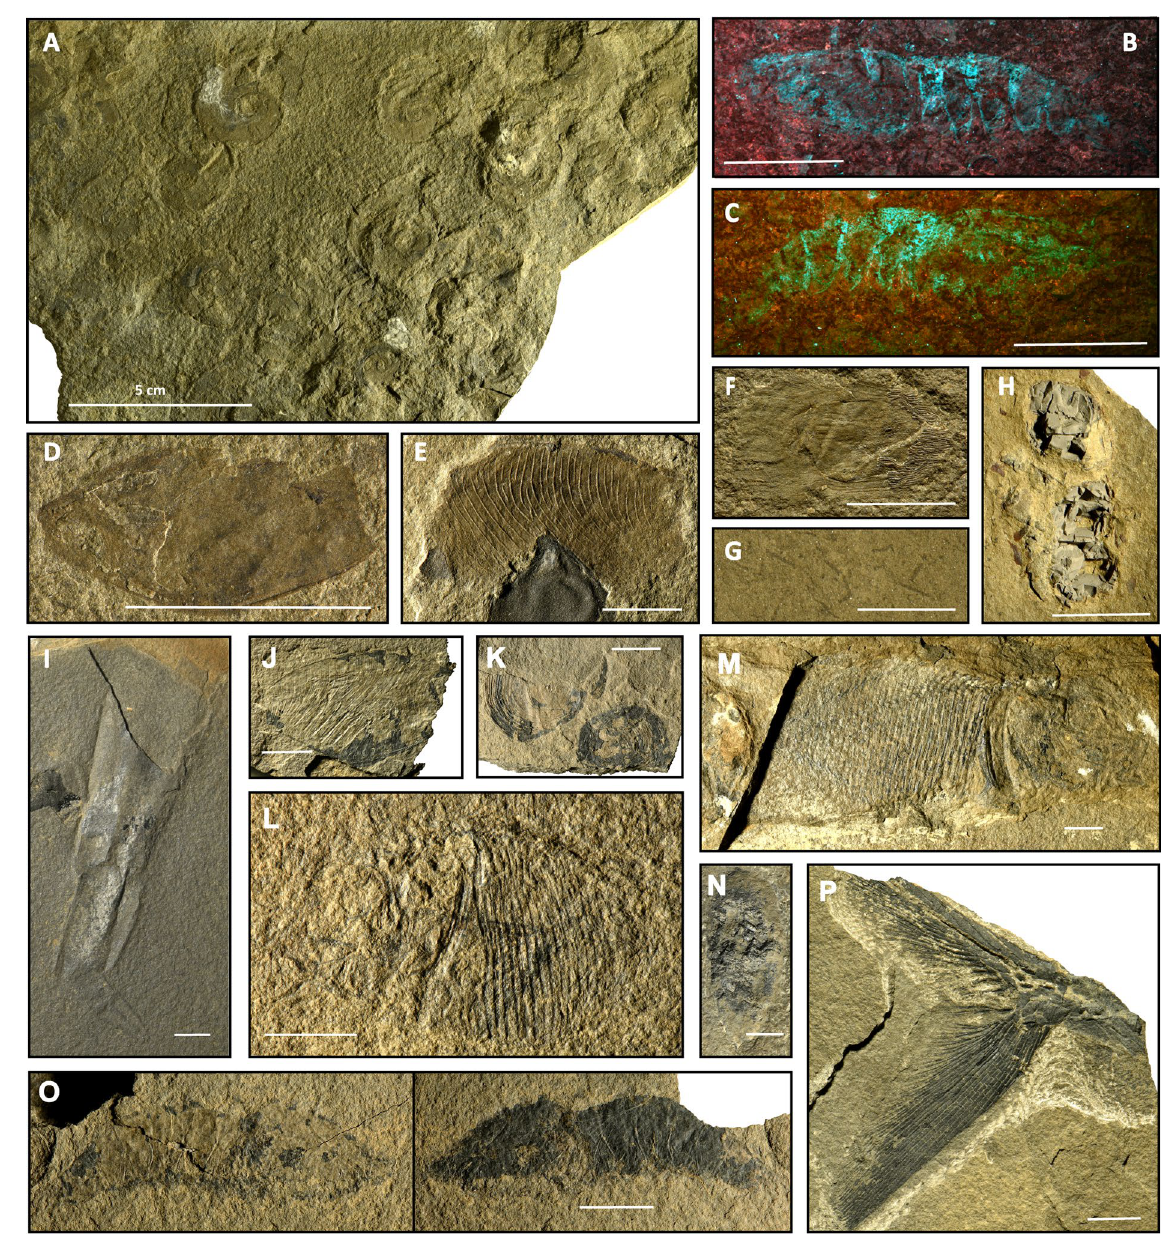
Figure 3. ( A – H ) Components of the GT fossil assemblage. ( I , J ) Components of the STW fossil assemblage. ( A ) Agglomerated ammonoids (UBGD33012) . ( B , C ) Penaeoid shrimps under UV light (UBGD33011a; UBGD33011b) . ( D ) Thylacocephalan Ligulacaris parisiana (UBGD33010) ( E ) Thylacocephalan Ankitokazocaris triassica (UBGD32321) . (F ) Isolated coelacanth scale (UBGD33009). ( G ) Algae accumulation (UBGD33008) . ( H ) Vertebrate coprolite (UBGD33007) . ( I ) Orthoconic nautiloid (UBGD33005). ( J ) Thylacocephalan Ankitokazocaris triassica (UBGD.IMNH2) . (K ) Brachiopod Orbiculoidea (UBGD33015) . ( L ) Fish Bobasatrania (UBGD.IMNH4). ( M ) Fish Bobasatrania sp. (IMNH_2740_51487) . ( N) Vertebrate coprolite (UBGD33006) . ( O ) Penaeoid shrimp (UBGD33014) . ( P ) Fish Bobasatrania sp. caudal fin (UBGD.IMNH3). Scale is 1 cm. Figure created using Adobe Illustrator (v.